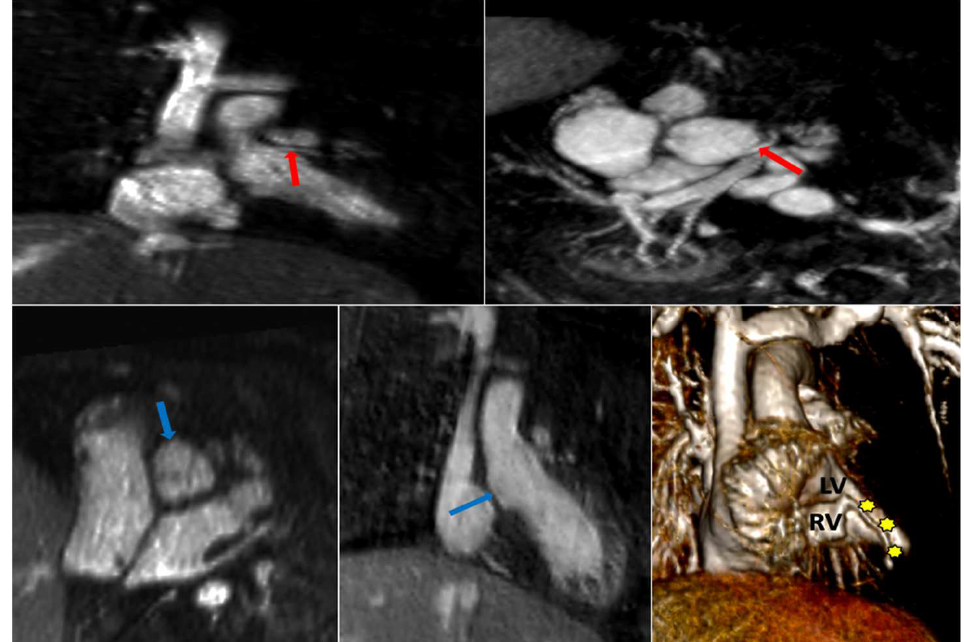
Figure 12. Absent Right Coronary Artery in Neonatal Pulmonary Atresia with Intact Ventricular Septum (PA-IVS). FE 4D MRA study (MUSIC) performed in a neonate on day 2 of life, reformatted in multiple planes, two showing normal origin of the left main coronary artery (red arrows), but right coronary ostial atresia (blue arrows). In the 3D volume rendered image, the right coronary artery (yellow stars) is seen arising directly from the right ventricular apex, consistent with right ventricle-dependent coronary circulation. Adapted with permission from reference [59]. RV = right ventricle; LV = left ventricle.